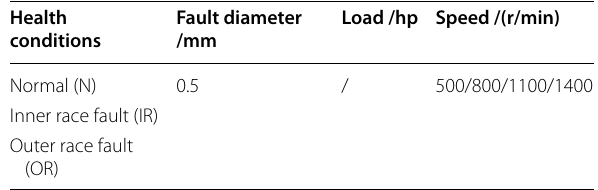
Table 2 Details of the OL bearing